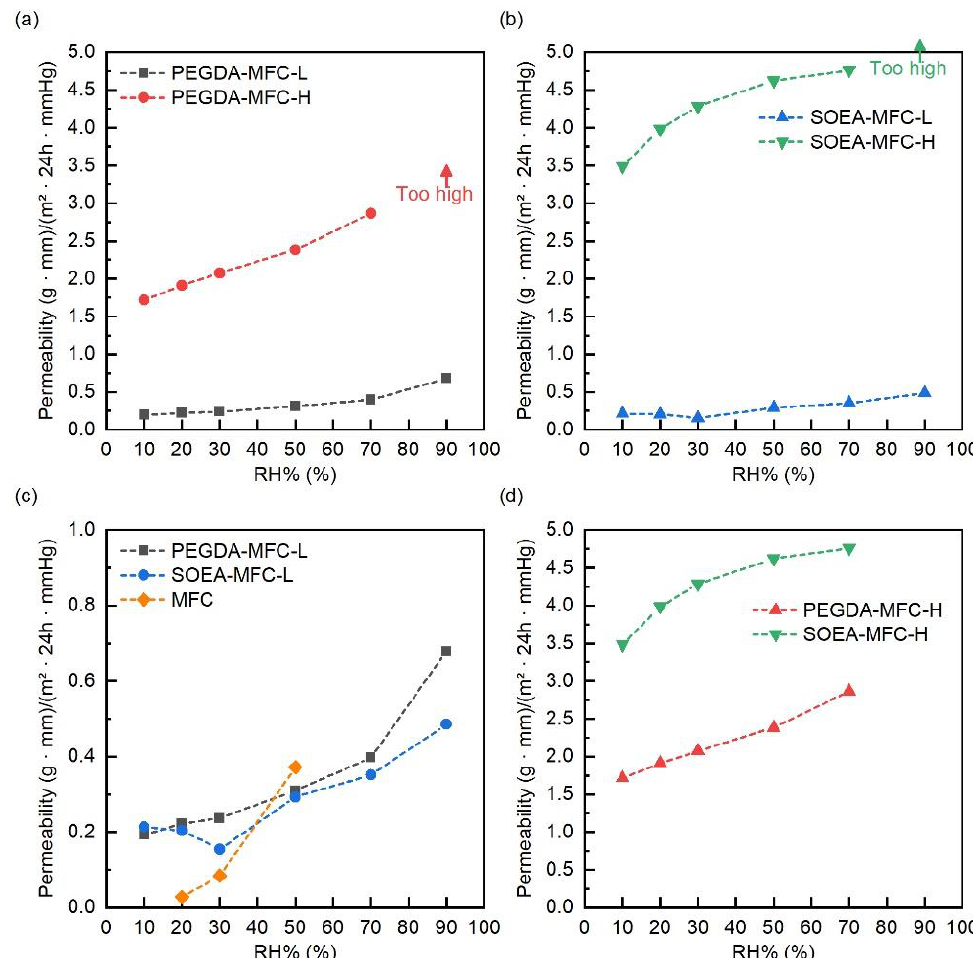
Figure 8. Water vapor permeability P [(g · mm)/(m² · 24h · mmHg)] as a function of relative humidity for ( a ) composites with PEGDA matrix; ( b ) composites with SOEA matrix; ( c ) composites with the